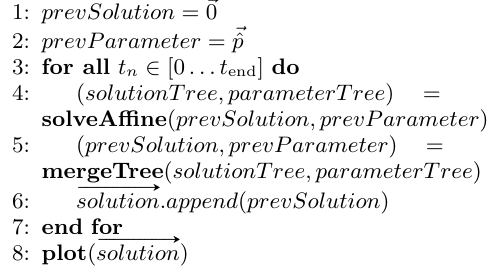
Figure 8: Affine transient simulation with merge strategy “Do not merge”